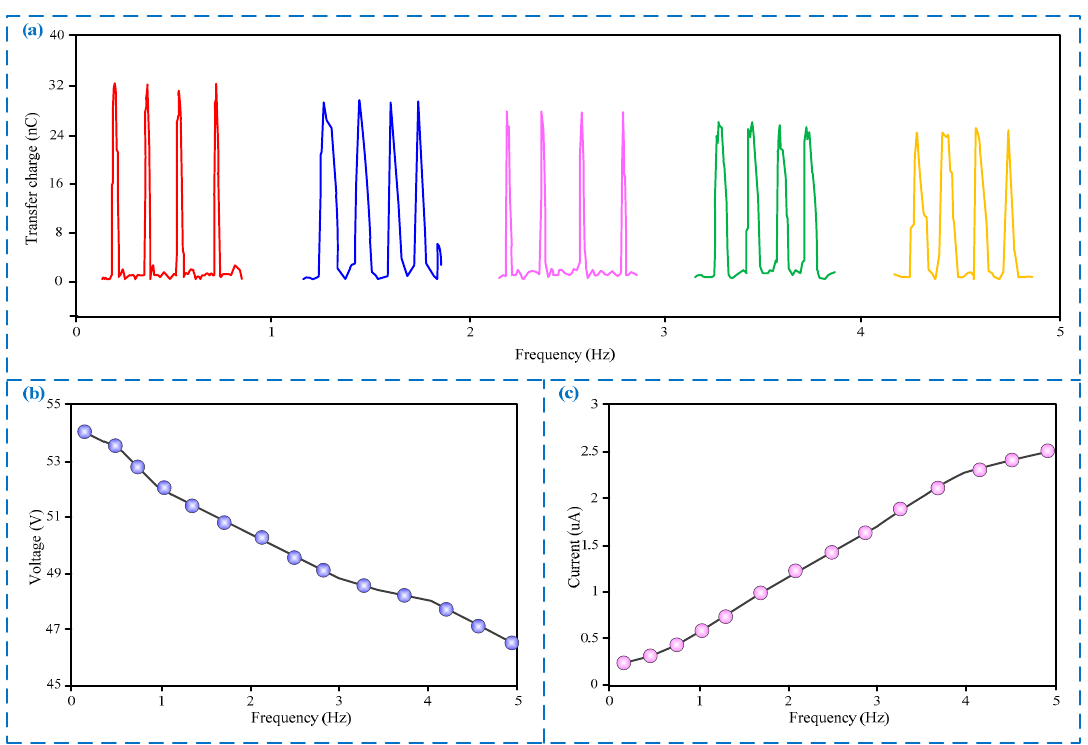
Figure 3. The output signal characteristics of the sensor under different frequencies. ( a ) Transferred charge under different frequencies; ( b ) output voltage under different frequencies; ( c ) output current under different frequencies.